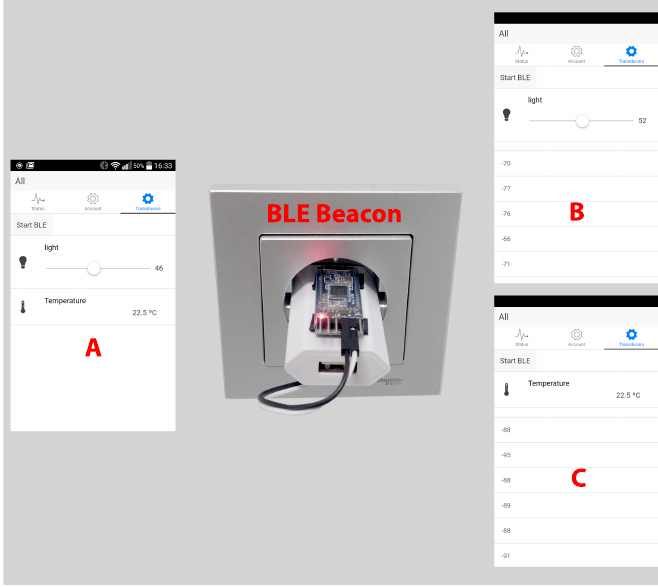
Figure 8. Android application in default ( A ) and BLE ( B , C ) modes and the BLE